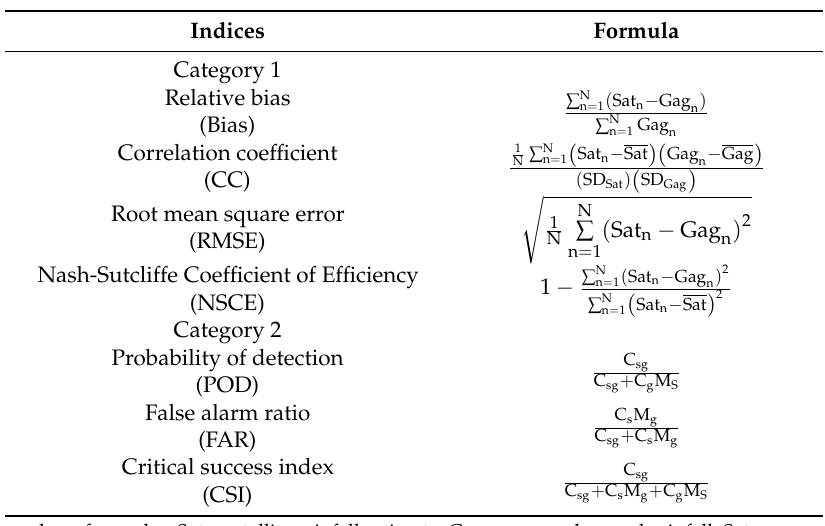
Table 2. Statistical Performance Measures Used for Evaluation of Satellite